Question: Describe this figure in one sentence.
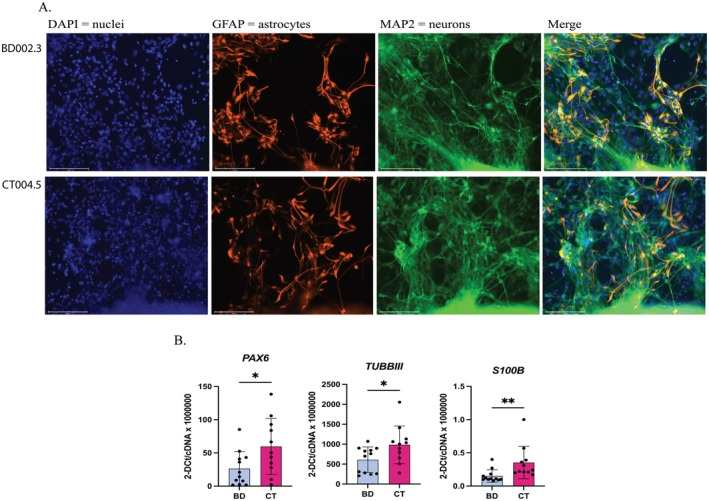
Answer: CNs characterisation. (A) Representative image of 2 cell lines neuronal and astrocytic markers. Immunofluorescence: Blue, DAPI = nuclei; green, MAP2 = neurons; orange, GFAP = astrocytes; merge. Scale bar = 150 μm. (B) QPCR results for neuroprogenitor, neurons and astrocytes. Data shows as mean in SD from the paired t ‐test for PAX6 ( p = 0.031) and β‐tubulin ( p = 0.035), and Mann–Whitney test for S100B ( p = 0.001).